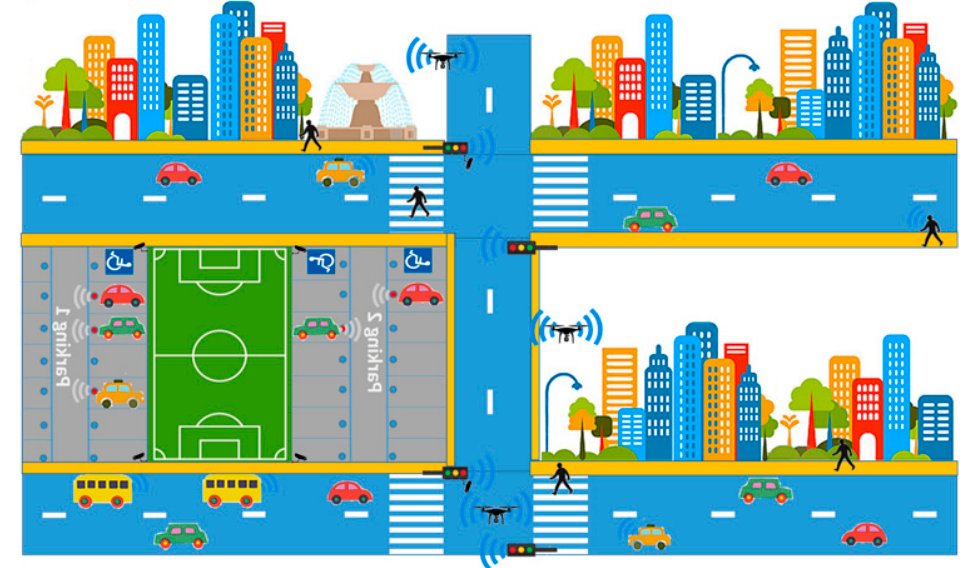
Figure 3. Citizen mobility management system.